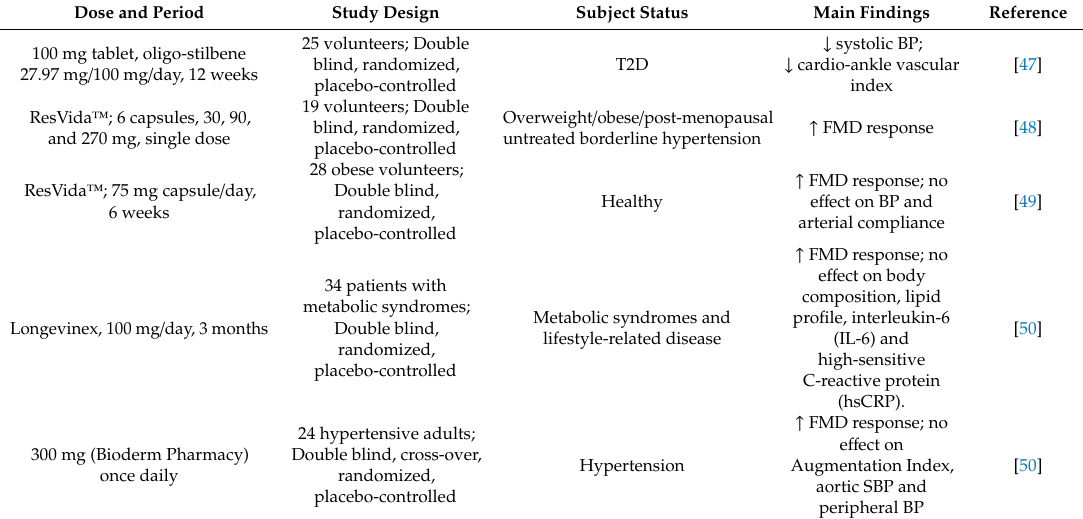
Table 1. Resveratrol improves endothelial function in metabolic syndromes or